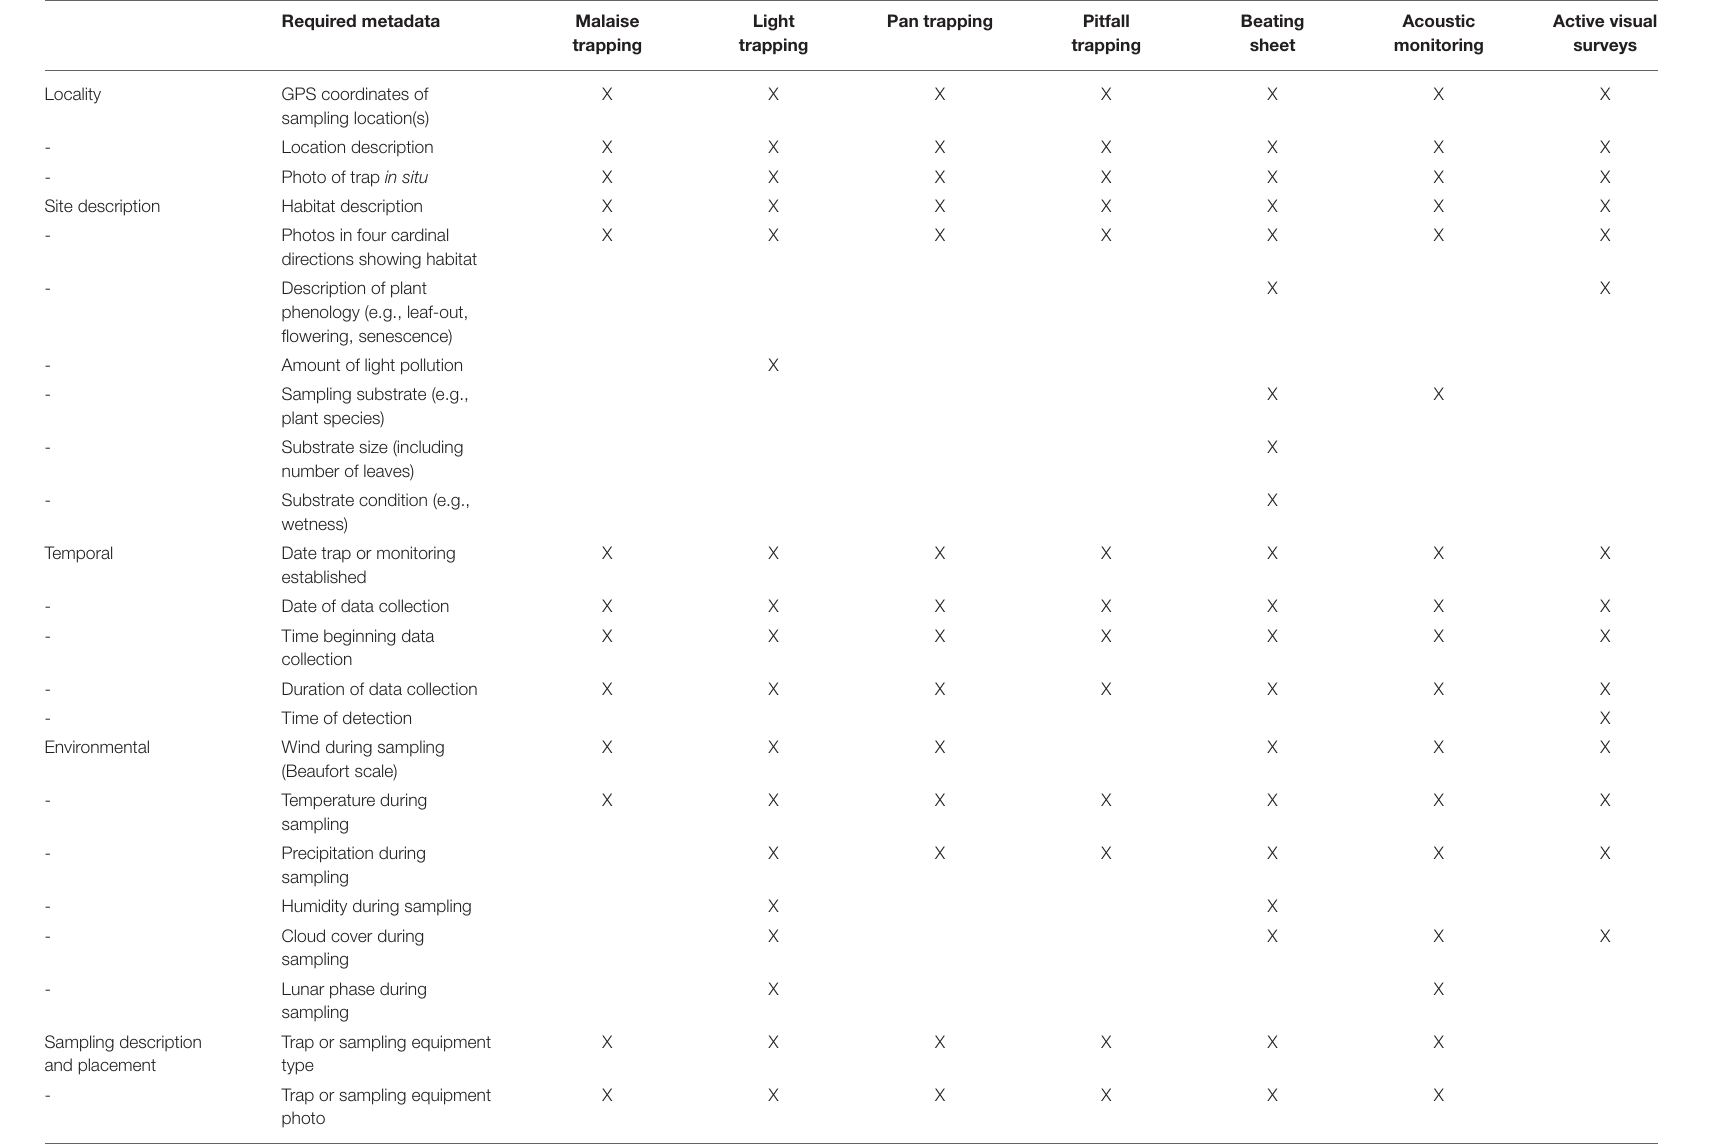
TABLE 1 | Recommended metadata for each of seven methods of insect